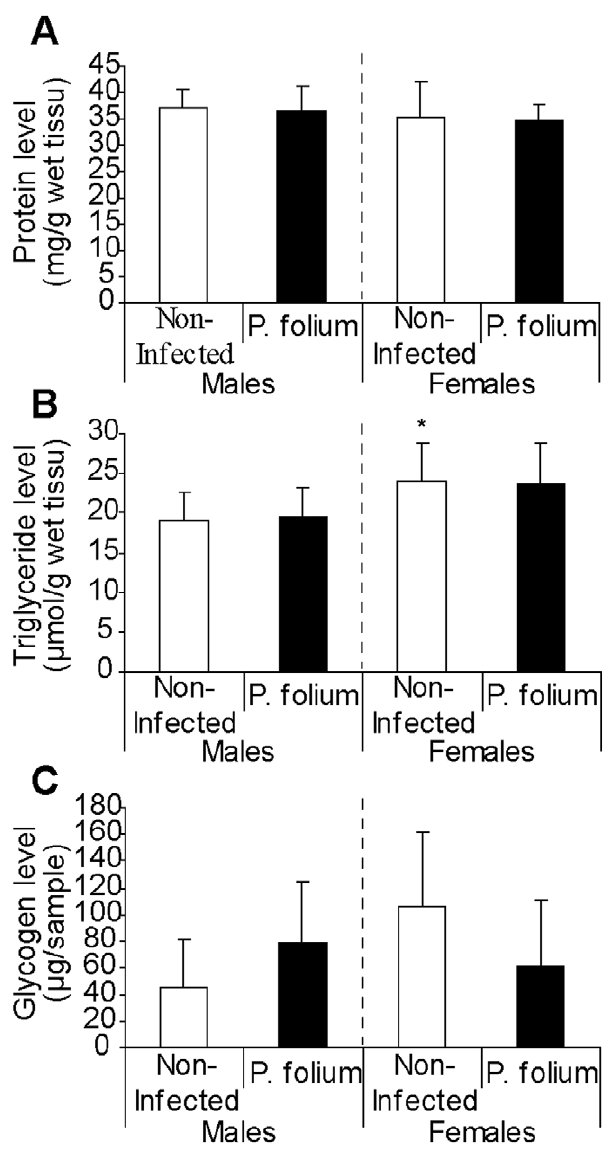
Figure 3. Gonadal energetic reserves of zebra mussels infected or not by P.folium . Energetic reserves available in gonads of zebra mussels, males and females, infected or not by P. folium (mean values 6 S.D.): ( A ) Protein, ( B ) Triglyceride and, ( C ) Glycogen levels. The asterisk means significant difference between non-infected males and females (p ,